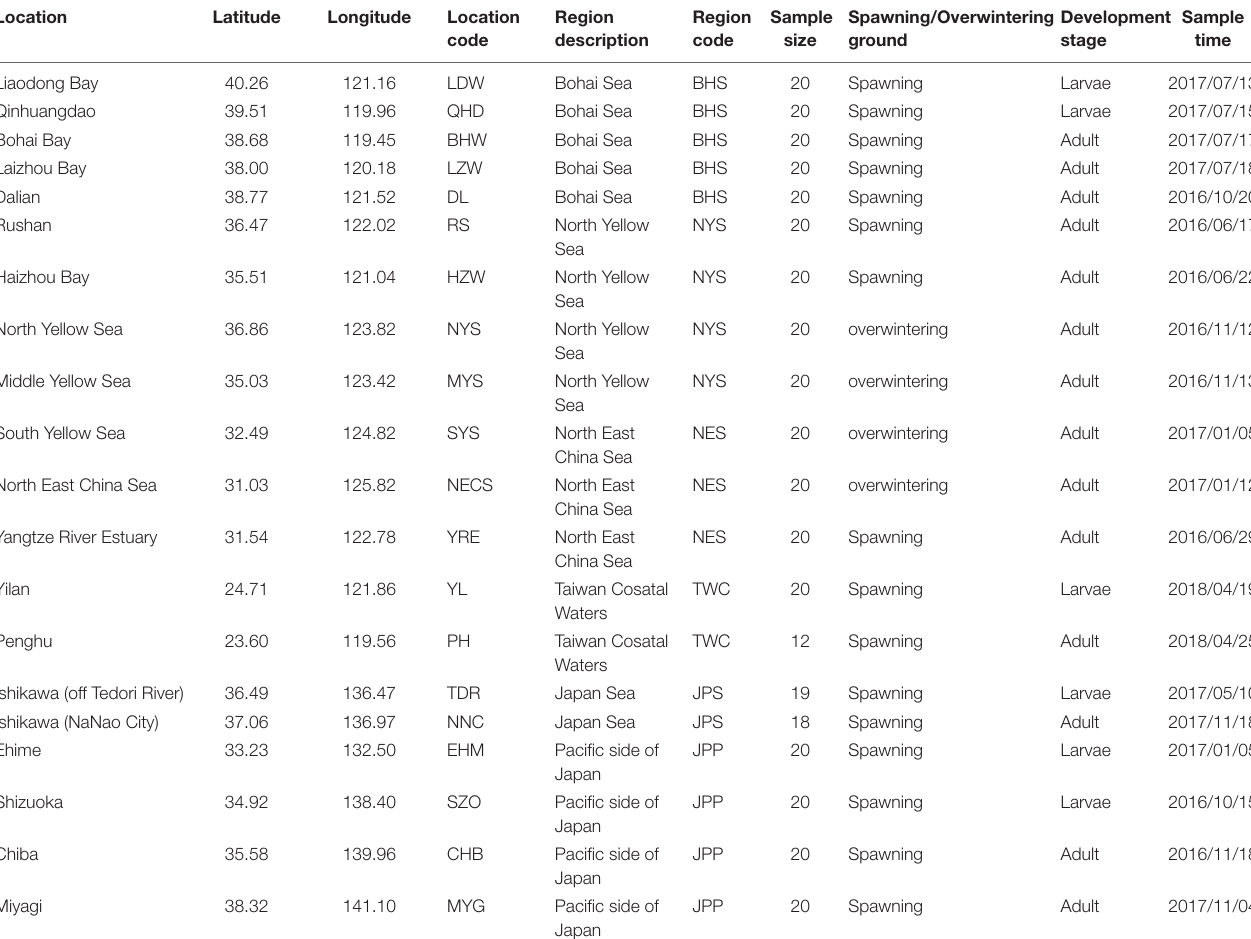
TABLE 1 | Sampling locations, regions, sample size and sampling time for each collection of E. japonicus .